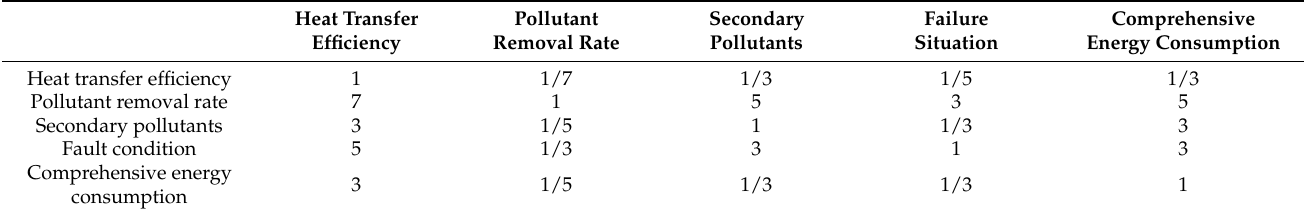
Table 4. Importance scale of the technical